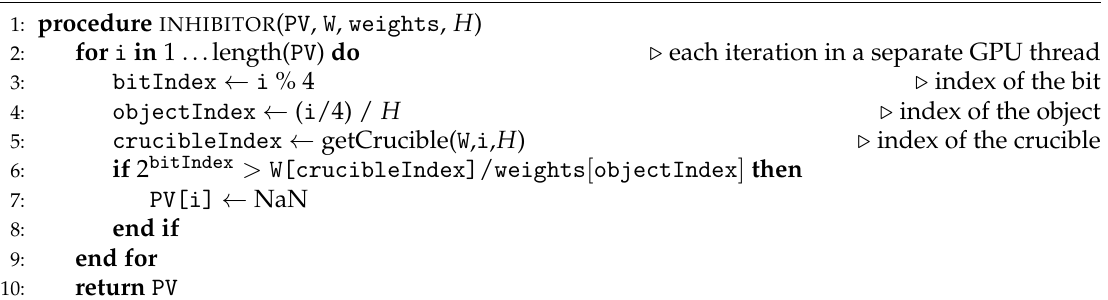
Algorithm 8 Discrete cGA: inhibitor().